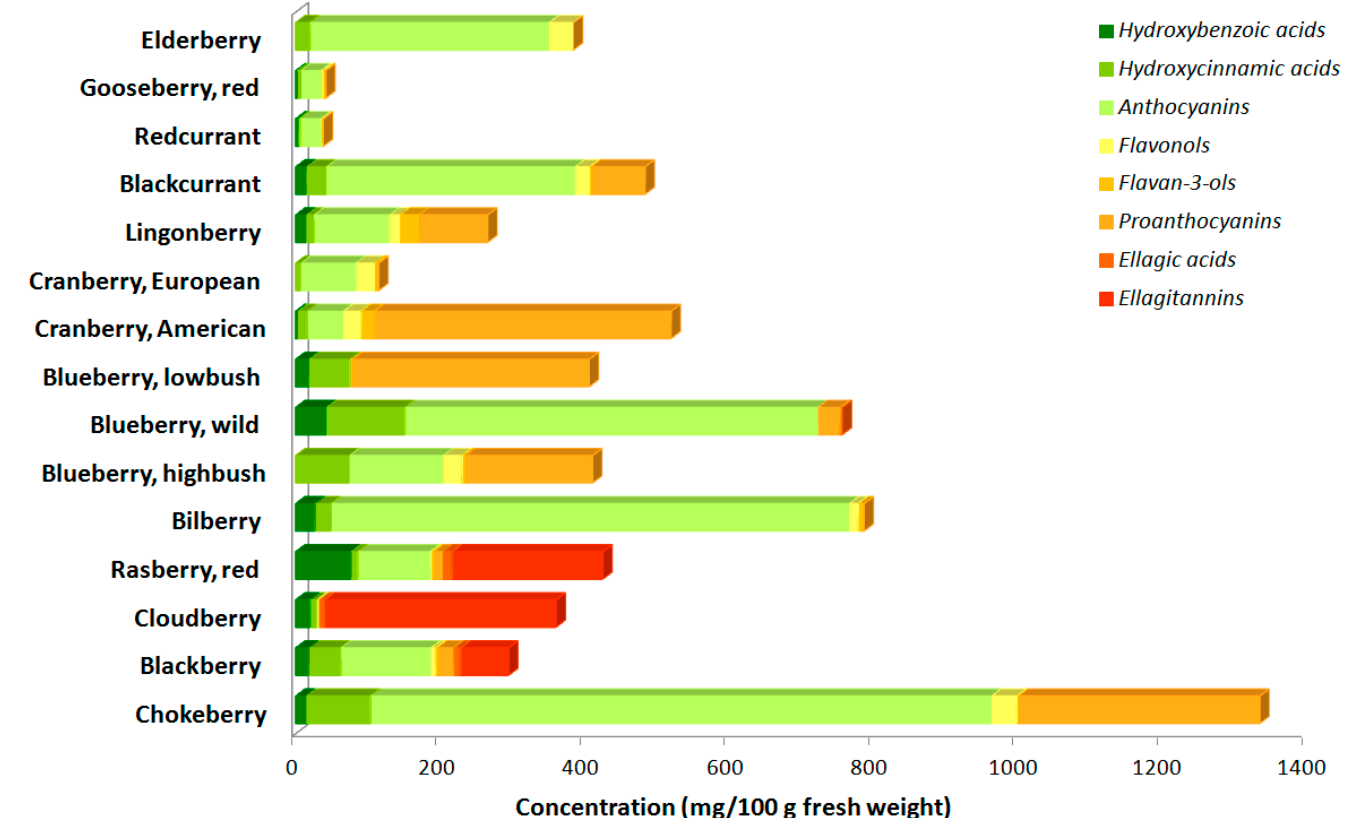
Figure 1. The phenolic composition of the commonest berries. Chokeberries ( Aronia mitschurinii) contain the highest concentration of bioactive compounds, mainly anthocyanins and proanthocyanins. Bilberry ( Vaccinium myrtillus ) is rich in anthocyanins, as well as wild blueberry ( Vaccinium corymbosum ), which also contains notable amount of phenolic acids. Lowbush blueberry ( Vaccinium angustifolium ) and the American cranberry ( Vaccinium macrocarpon ) are sources of proanthocyanidins. The berries of the genus Rubus , i.e. , raspberry ( Rubus idaeus ), cloudberry ( Rubus chamaemorus ), and blackberry ( Rubus fruticosus ) contain all the principle bioactive compounds that we meet in berries, and especially ellagitannins. Gooseberry ( Ribes uva-crispa ) and red currant ( Rubus rubrum ), on the other hand, contain mainly phenolic acids and only traces of the other compounds.